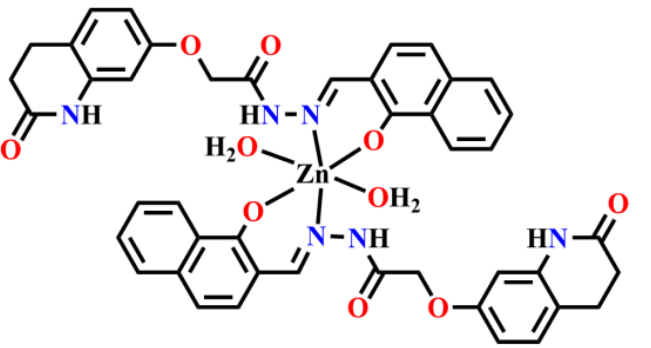
Figure 62. A symmetric Zn(II) complex of two of the same 1-hydroxylnaphthylhydrazones with an acylhydrazone derivative as a side chain.